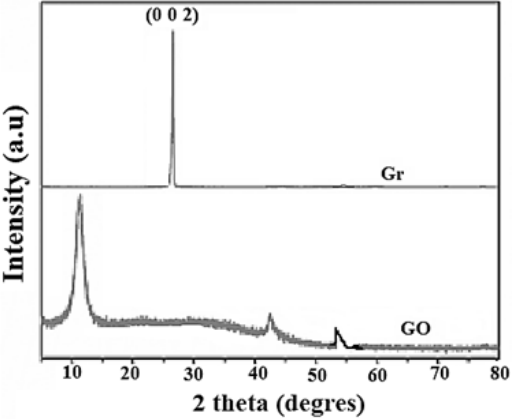
ff raction patterns corresponding to graphite and graphene. Figure 5. X-ray diffraction patterns corresponding to graphite and graphene. Figure 5. X-ray di